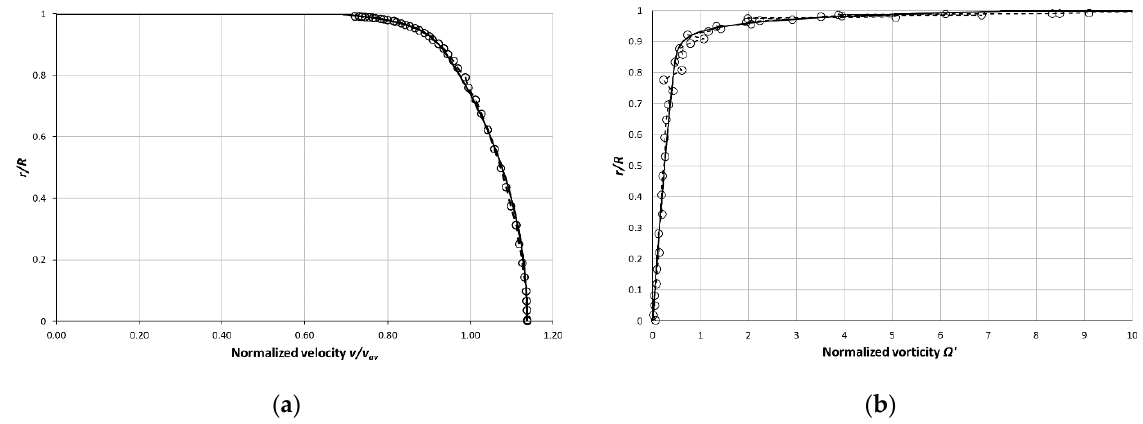
Figure 12. The analytical formula comparison with the experimental data (PSP) for Re = 13,598,000, using K and N as the variables. Dashed line with circles represents the experimental data, the solid line is the analytical profile. ( a ) Normalized mean velocity profile, ( b ) Normalized vorticity distribution.